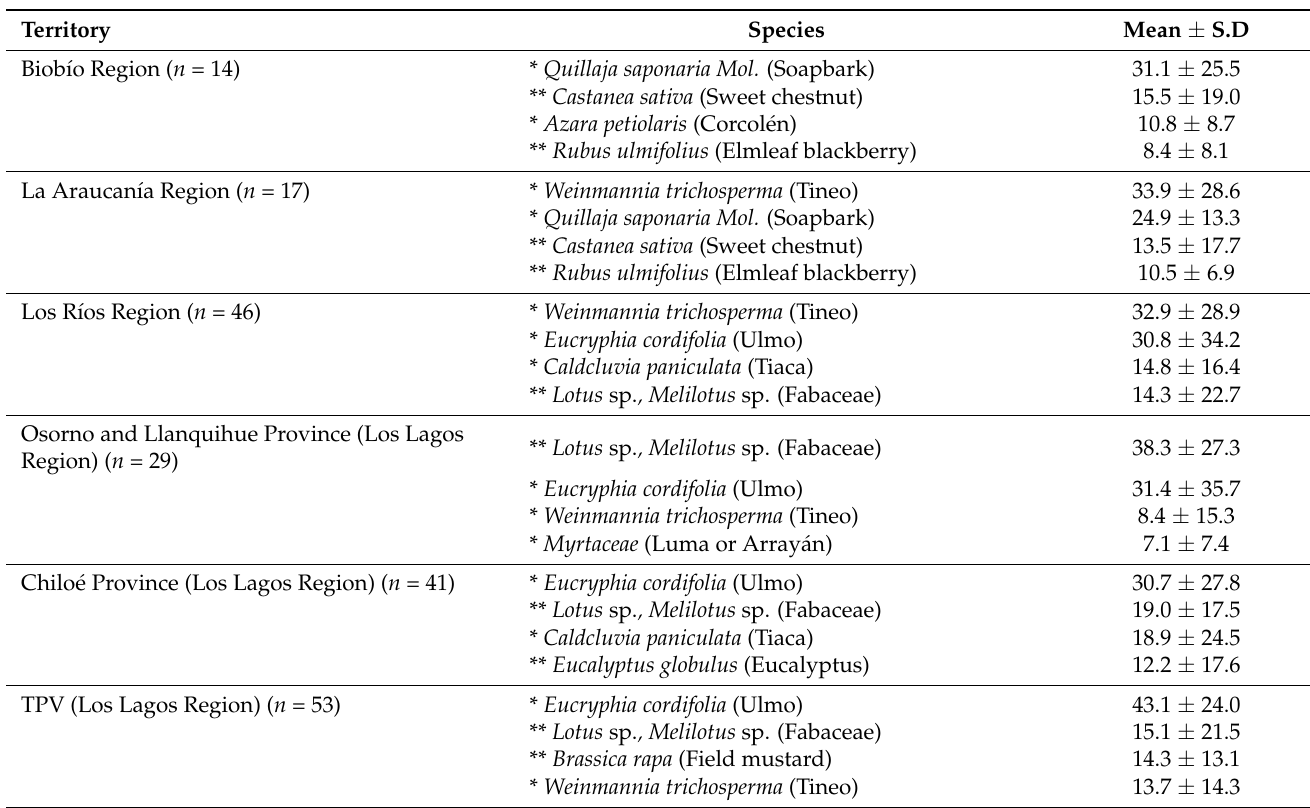
Table 3. Main botanical species found in the pollen profile of honeys studied by territory (% of